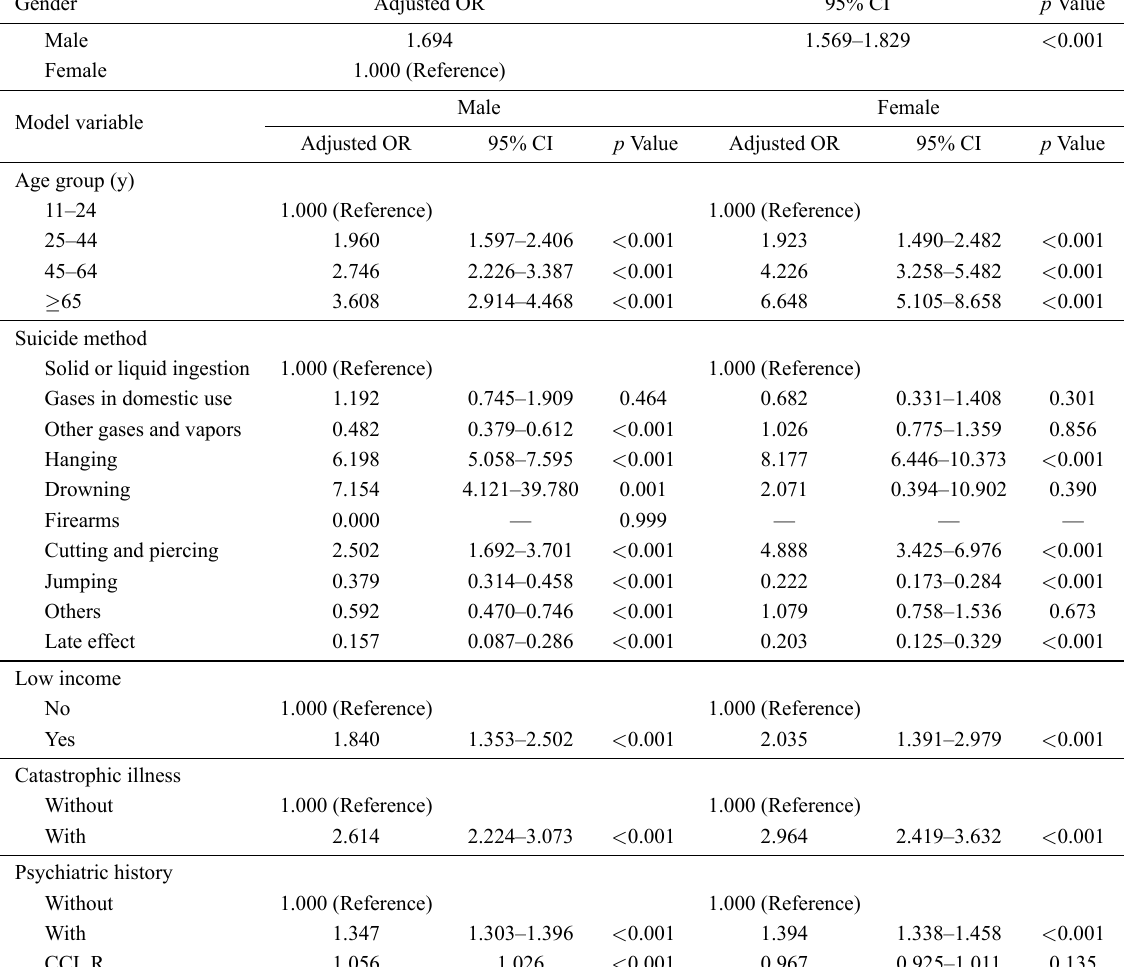
Table 2. Factors of suicide prognosis using multivariable logistic